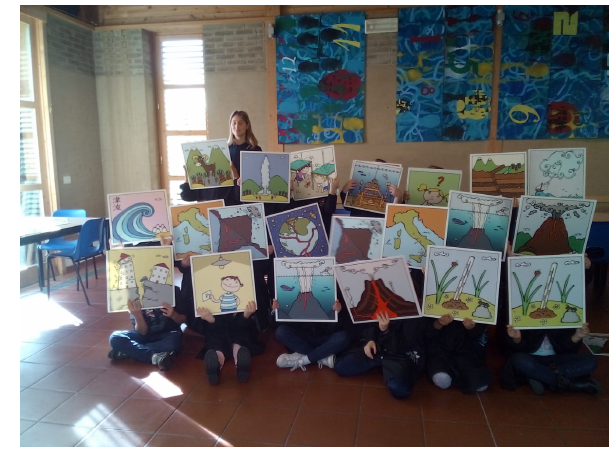
Figure 5. The educational laboratory INGV-memory game at the Istituto comprensivo di Vezzano Ligure –